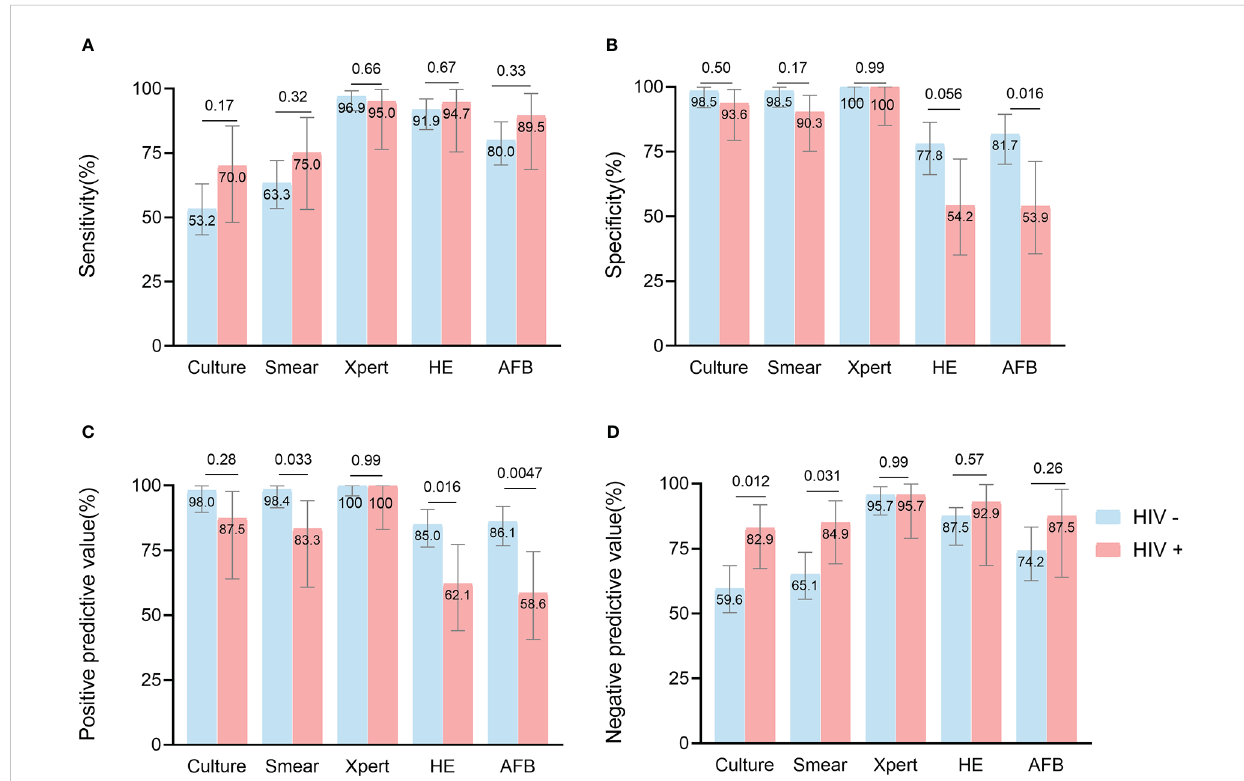
FIGURE 3 Head-to-head comparison of test accuracy in biopsy samples, by HIV status. Data are shown strati fi ed according to: (A) sensitivity, (B) speci fi city, (C) positive predictive value, (D) negative predictive